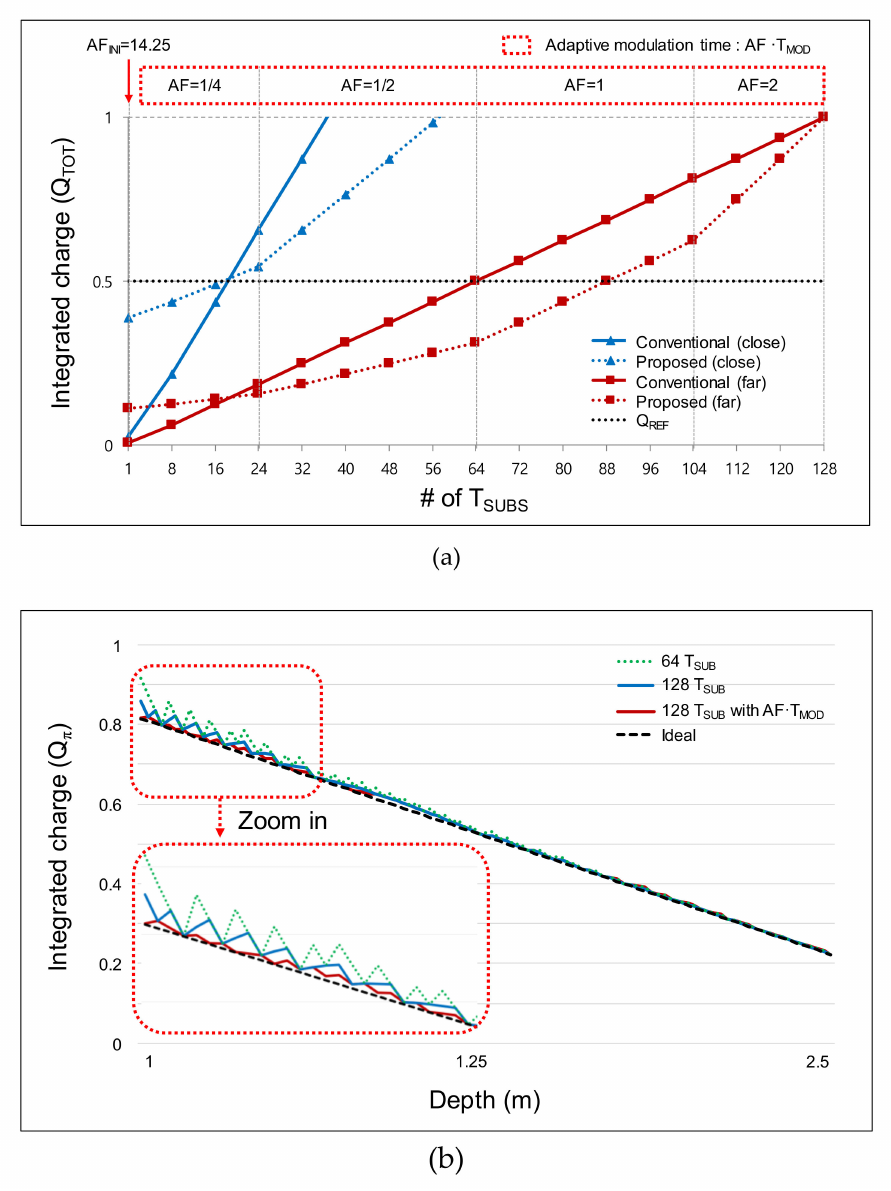
Figure 4. ∆ Q π simulated using the two-step comparison scheme: ( a ) accumulated ∆ Q π according to the accumulation in each sub-integration time T SUB ; ( b ) ∆ Q π acquired from the first comparison